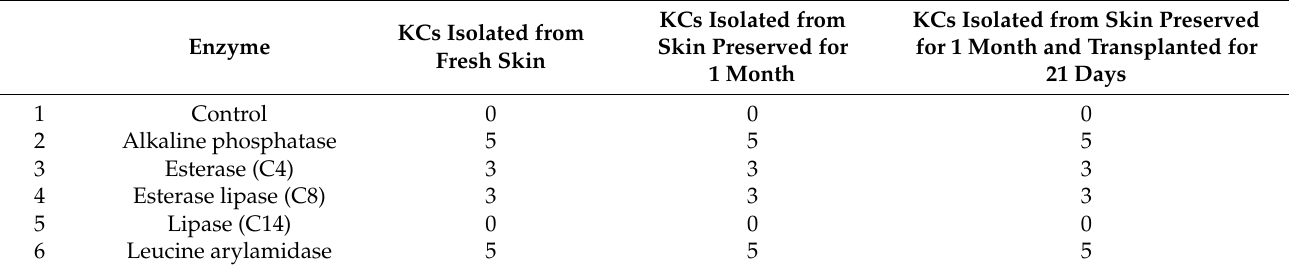
Table 3. Metabolic activity of keratinocytes.